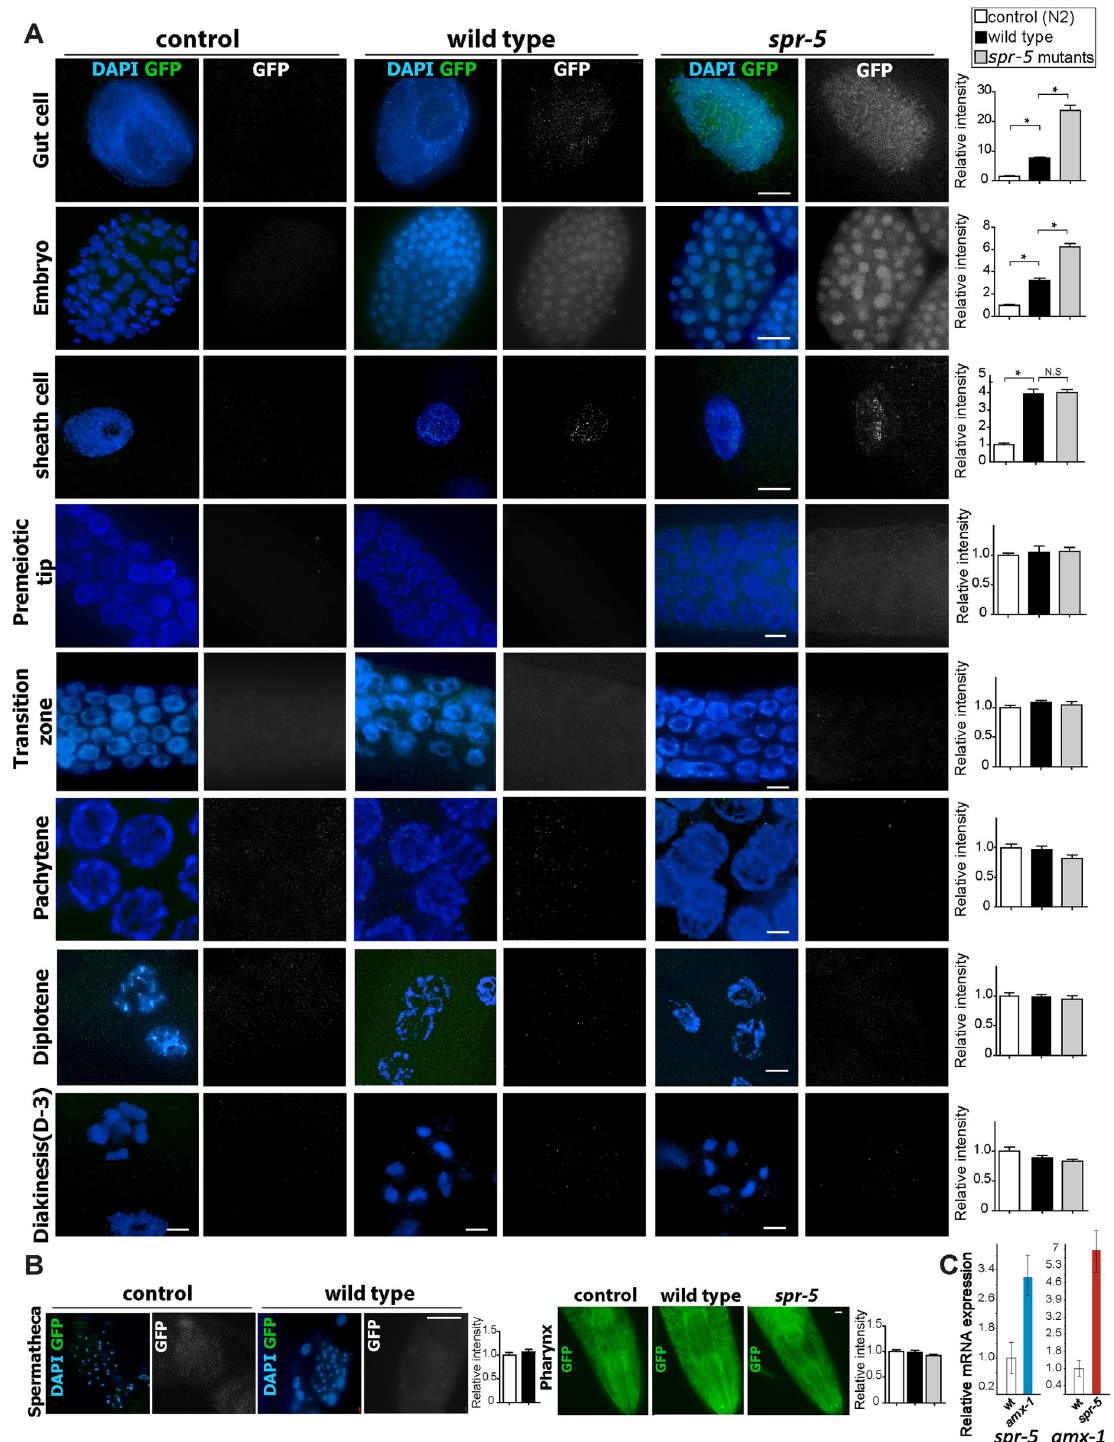
Fig 3. AMX-1 is expressed in the nuclei of gut, embryonic and sheath cells and is further upregulated in absence of SPR-5. (A) Immunolocalization of AMX-1-GFP utilizing an anti-GFP antibody in the indicated mitotic cells and at different stages in the gonads of control (N2 worms), wild type ( amx-1 :: GFP worms) and spr-5; amx-1 :: GFP worms. AMX-1-GFP signal is detected in the nuclei of mitotic cells including gut, embryonic and sheath cells. The absence of SPR-5 expression results in increased AMX-1 signal in mitotic cells. Right, relative intensity of AMX-1 expression measurements. � P < 0.0001 by the two-tailed Mann–Whitney test, 95% C.I. No distinct signal is